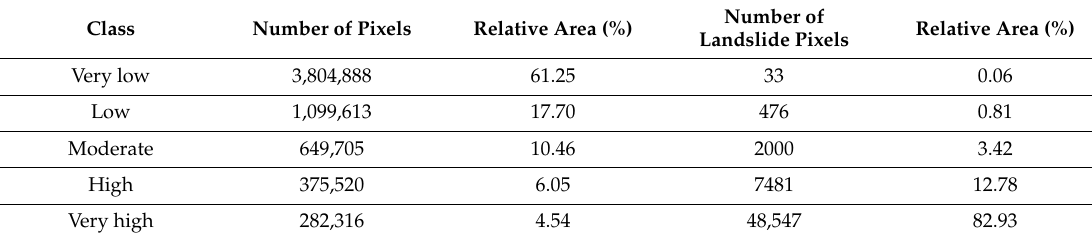
Table 2. Percentages of di ff erent landslide susceptibility classes and existing landslide pixels.